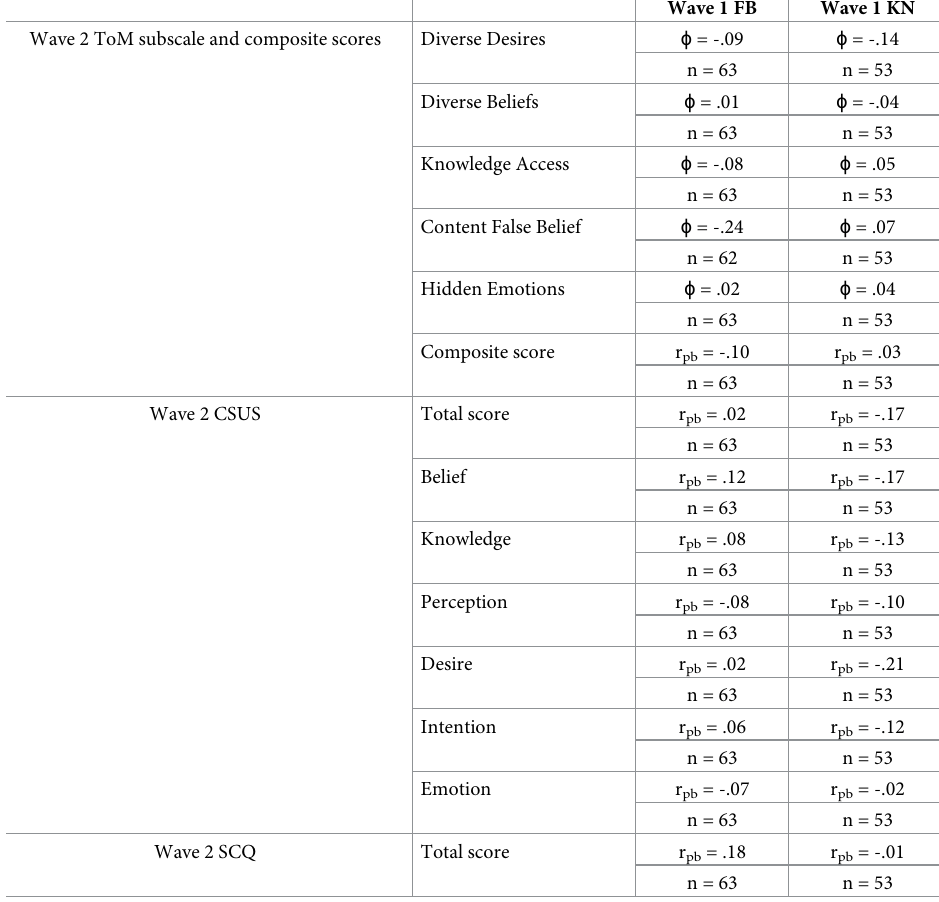
Table 3. Zero-order correlations between tasks at Wave 1 and Wave 2 in Experiment